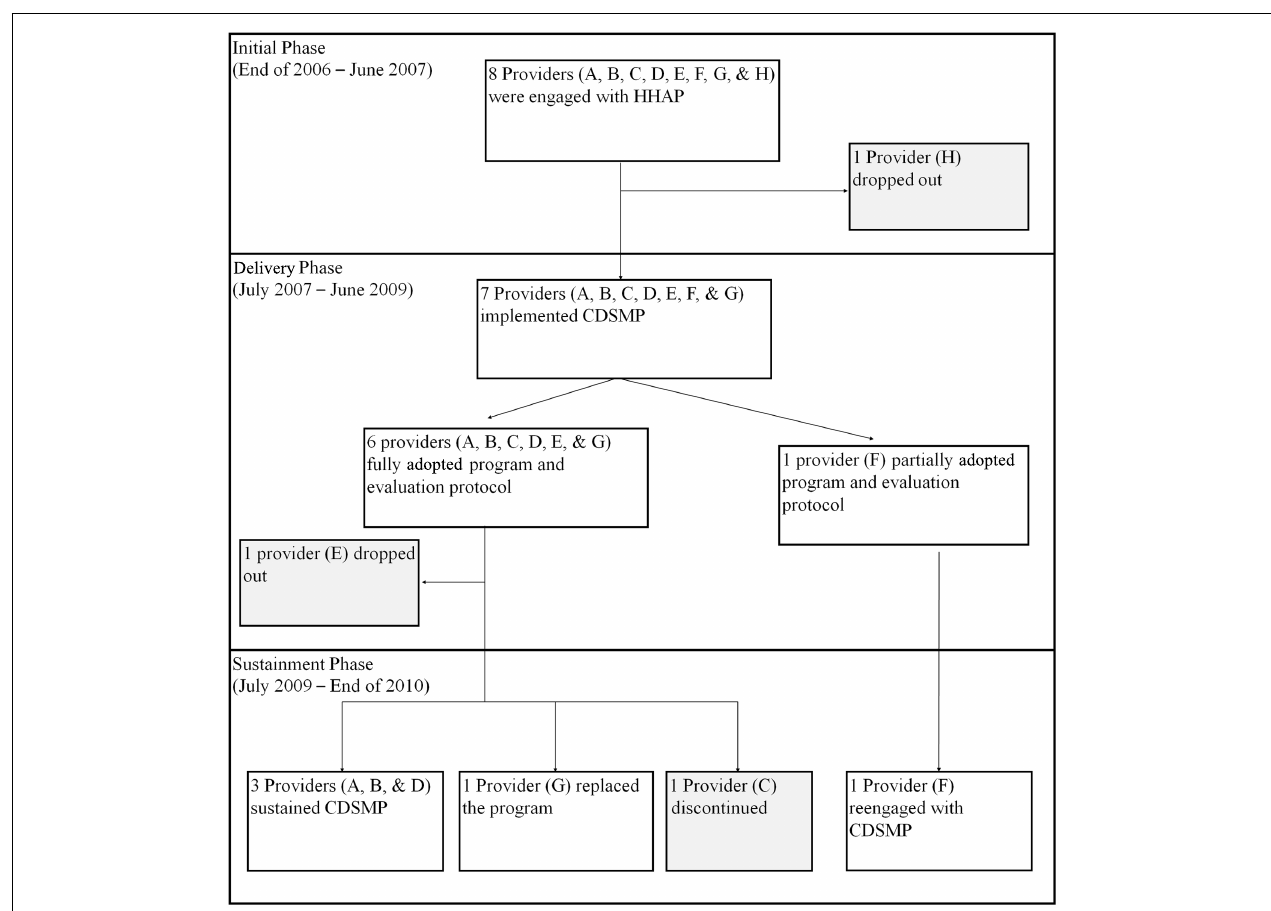
FIGURE 1 | Providers progress over the 4years